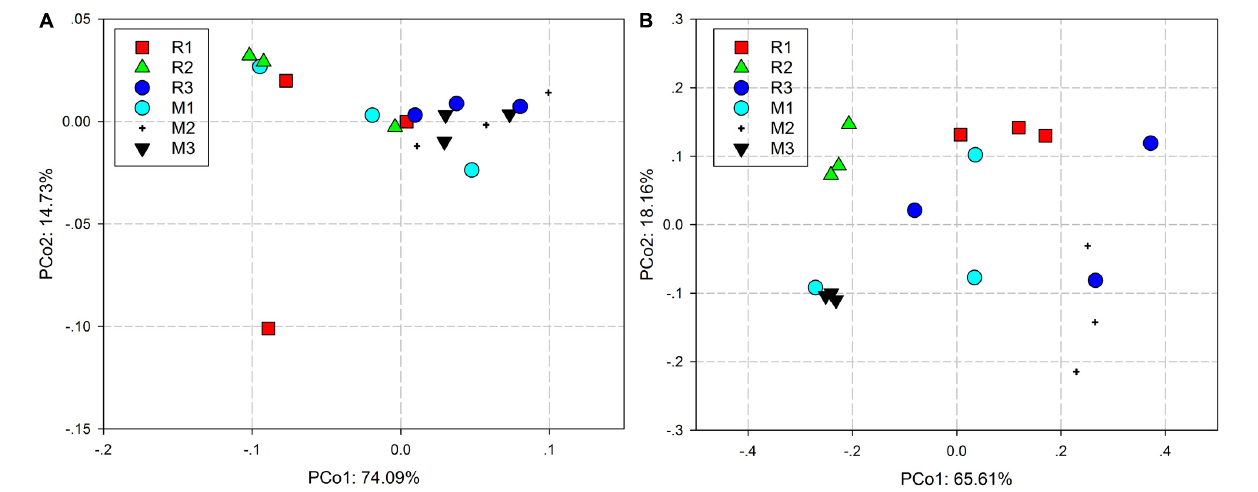
FIGURE 4 | PCoA bacterial communities of C. medinalis fed on different host plants over generations based on weighted UniFrac (A) and Bray–Curtis (B) distances. M1–M3: the first to third generation of C. medinalis fed on maize; R1–R3: the first to third generation of C. medinalis fed on rice.